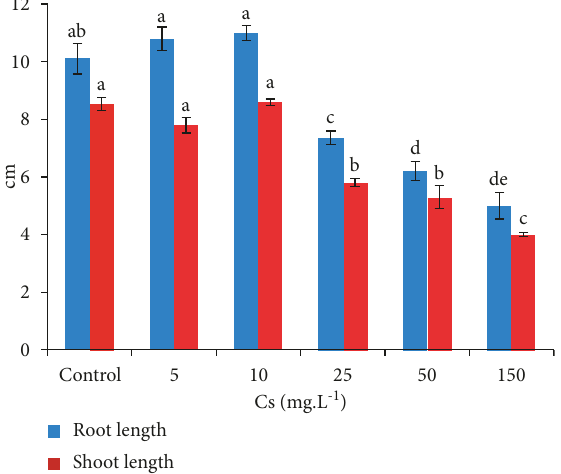
Figure 2: Effect of cesium on root and shoot length of S. portulacastrum. All the values are mean of twelve readings ± S.E. One-way ANOVA significant at p ≤ 0.05. Different letters indicate significantly different values in root or shoot (DMRT p ≤ 0.05).